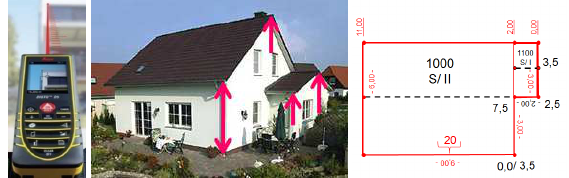
Figure 12. Cadastral measurement of a building